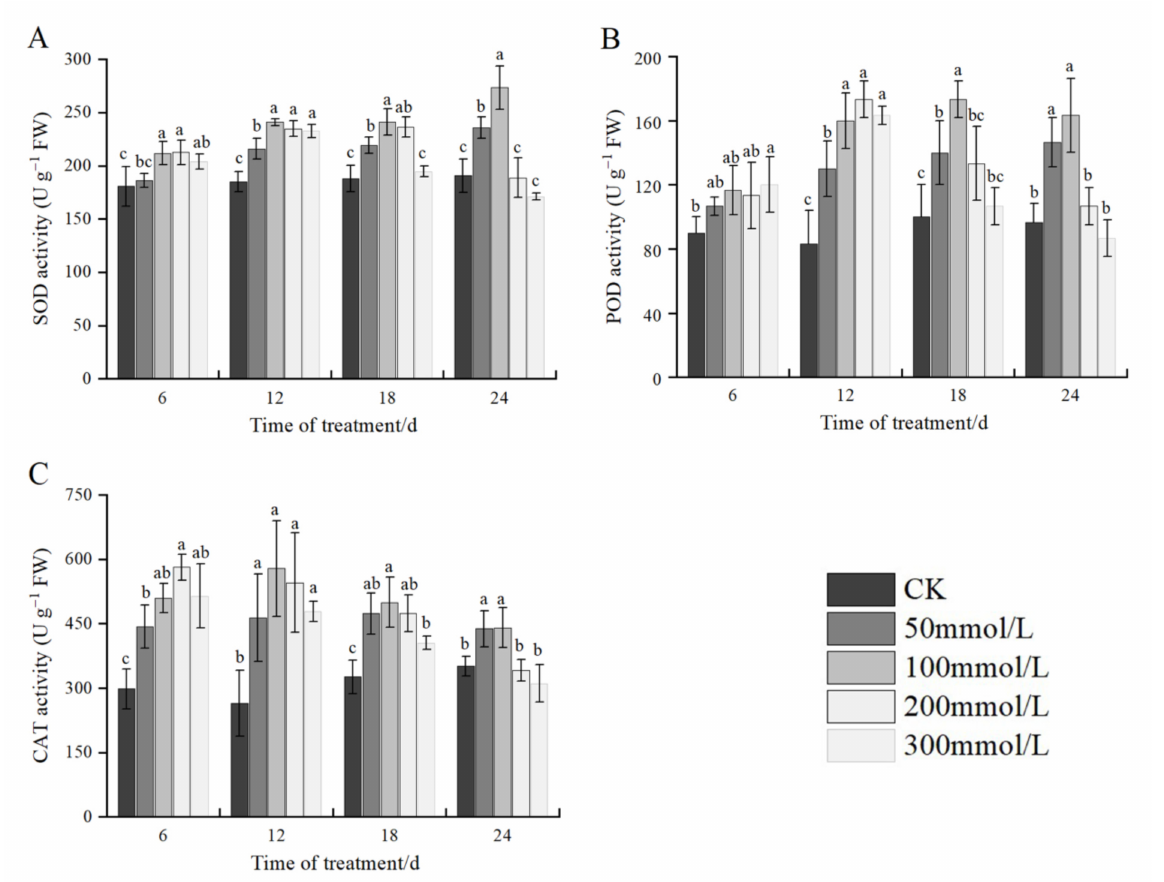
Figure 5. Effect of salt stress on the activities of antioxidant enzymes in leaves of J. microcarpa L. seedlings. ( A ) Superoxide dismutase (SOD) activity, ( B ) peroxidase (POD) activity, and ( C ) catalase (CAT) activity of leaves. Error bars indicate the SD of treatment means. Different letters on the bars indicate significant differences among the treatments ( p <